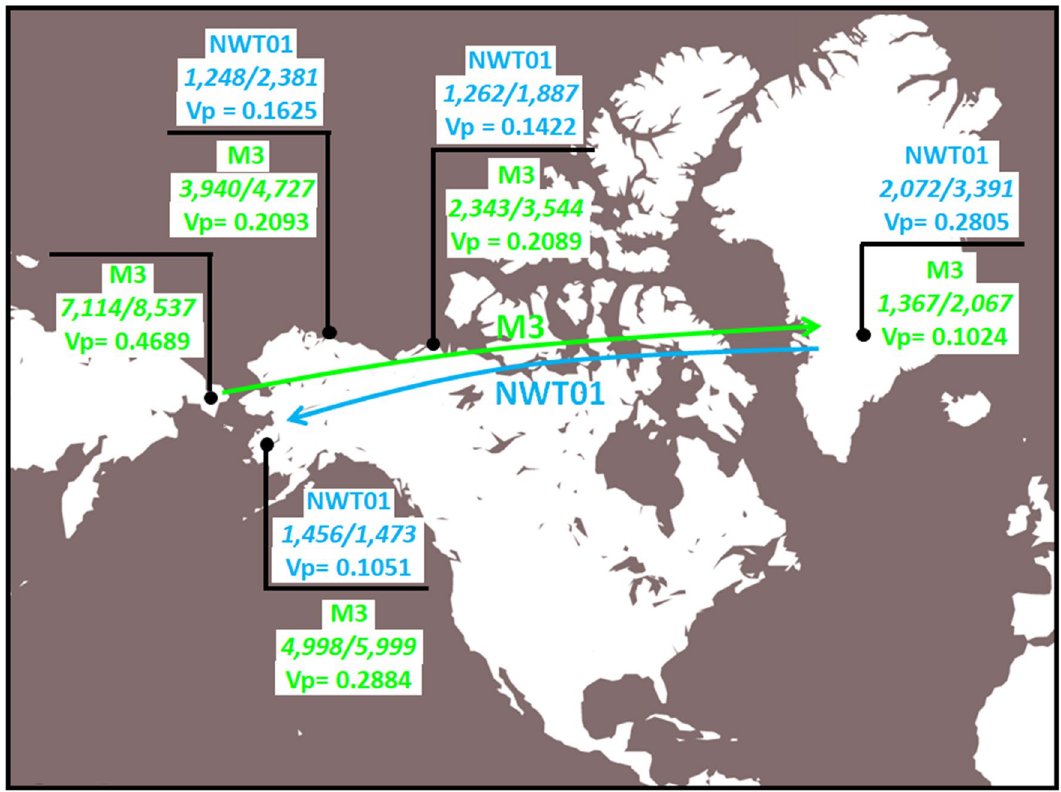
Figure 5. Circumpolar movement of Q-M3 and Q-NWT01 lineages (numbers in italics = age in